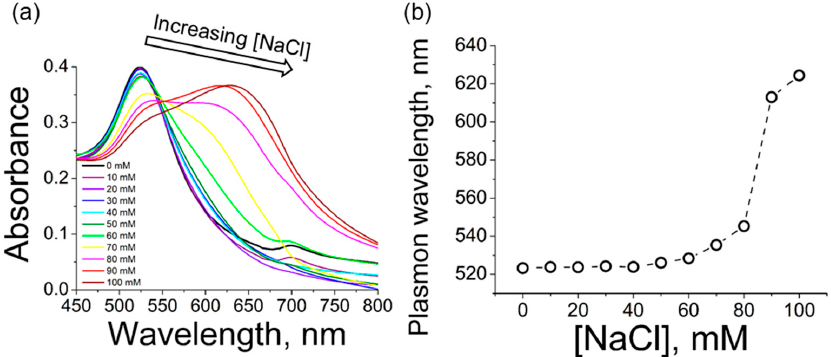
Figure 1. Citrate-capped gold nanoparticles. ( a ) Transmission electron microscopy image of the gold nanoparticles. ( b ) Histogram including the values of size of the gold nanoparticles.